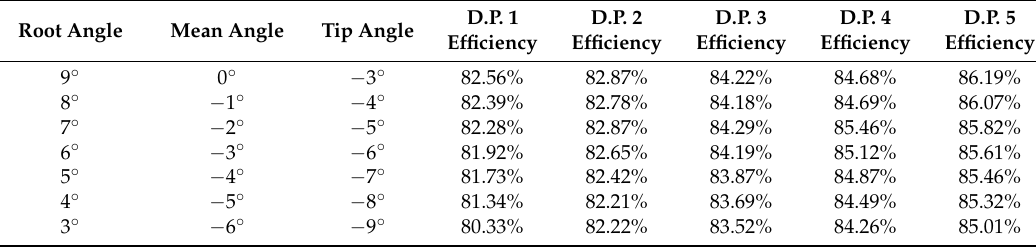
Table 17. VGT analysis of each mass flow rate against the respective change in the stator profile.